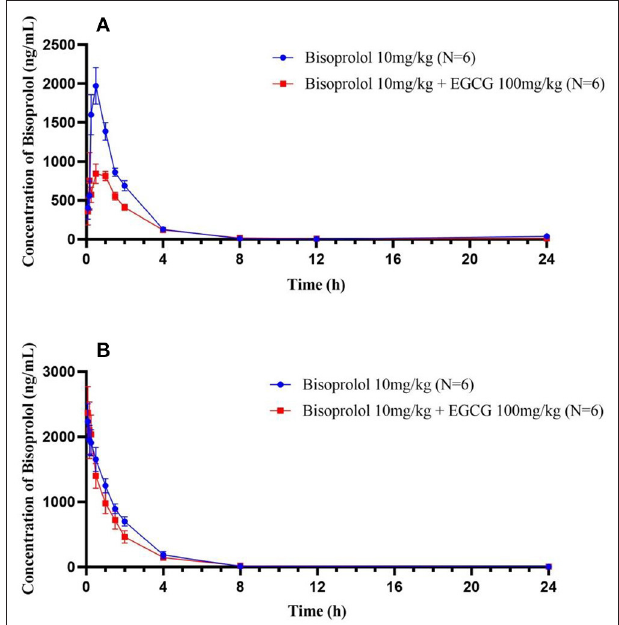
FIGURE 3 | The plasma concentration time curves of bisoprolol after oral (A) and intravenous (B)